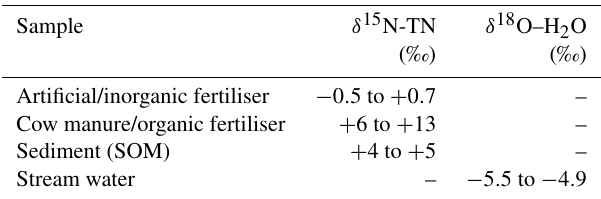
Table 1. The isotopic compositions of potential sources of NO − the catchment.